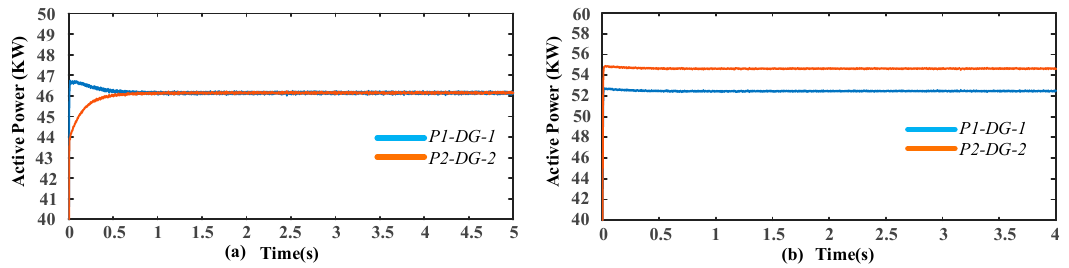
Figure 9. ( a ) Inverter terminal and load voltages for the conventional control strategy; ( b ) inverter terminal and load voltages for proposed control strategy.